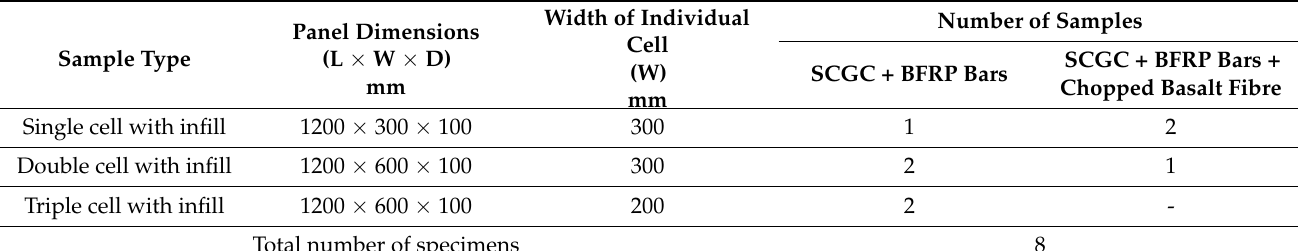
Table 2. Details of panels for